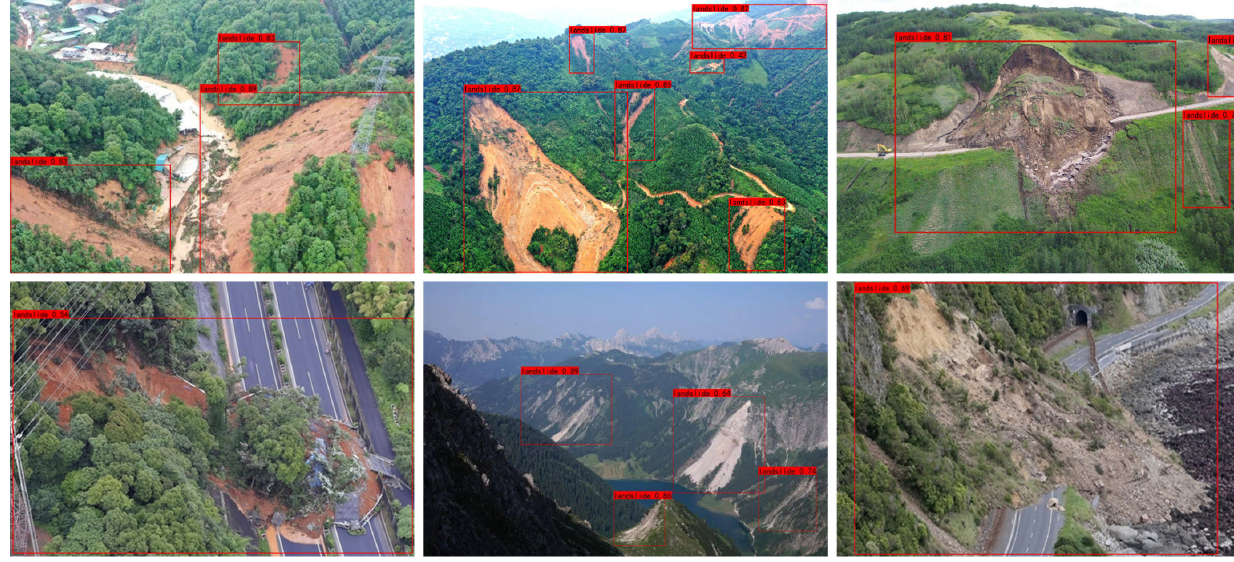
Figure 15. Detection results of UAV landslide image area by